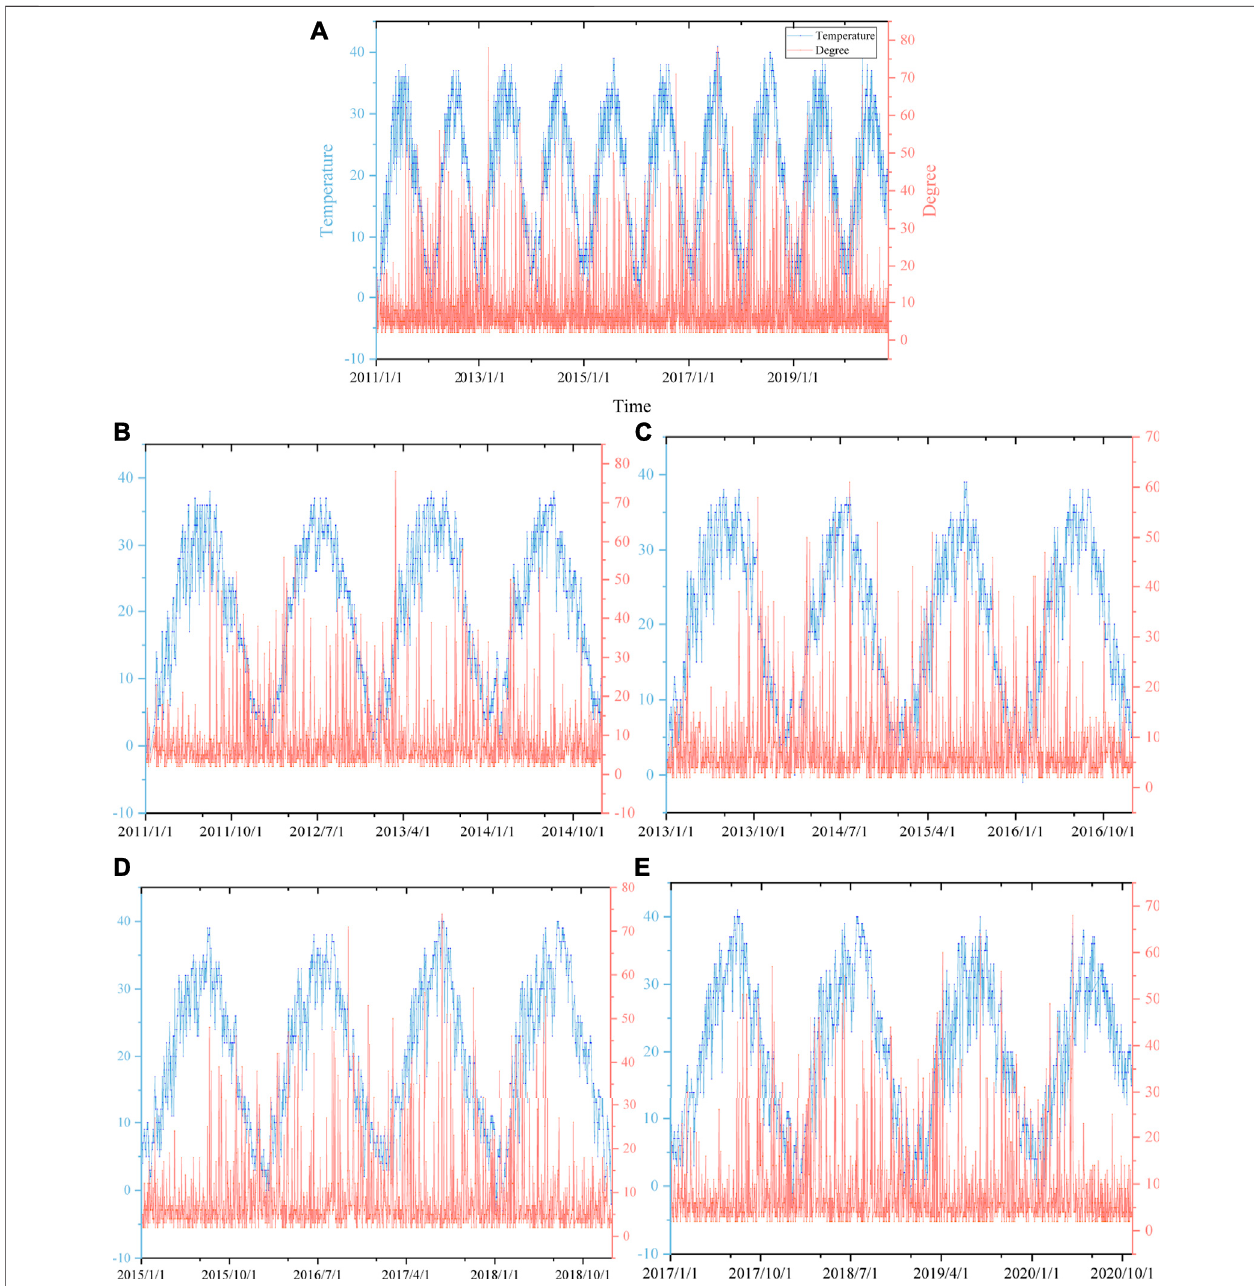
FIGURE3| TemperatureandnetworkdegreeinXi ’ an. (A) isaglobalnetwork, (B – E) isawindownetworkwithalengthof4 years.In (A – E) ,theabscissaistime,the left ordinate is temperature, and the right ordinate is the degree of the network at the same time point.